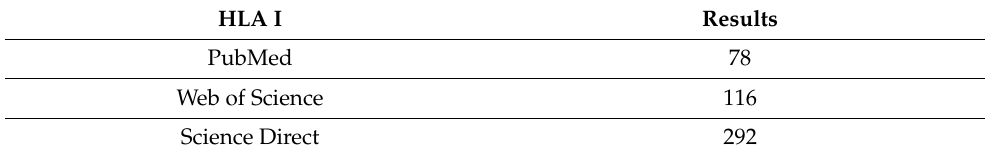
Table 4. Results retrieved through systematic search on PubMed, Web of Science and Science Direct of HLA II allelic frequencies in the Colombian population (date consulted: 24 February 2021). Results of Results of Results of HLA II Query #1 Query #2 Query #3 PubMed